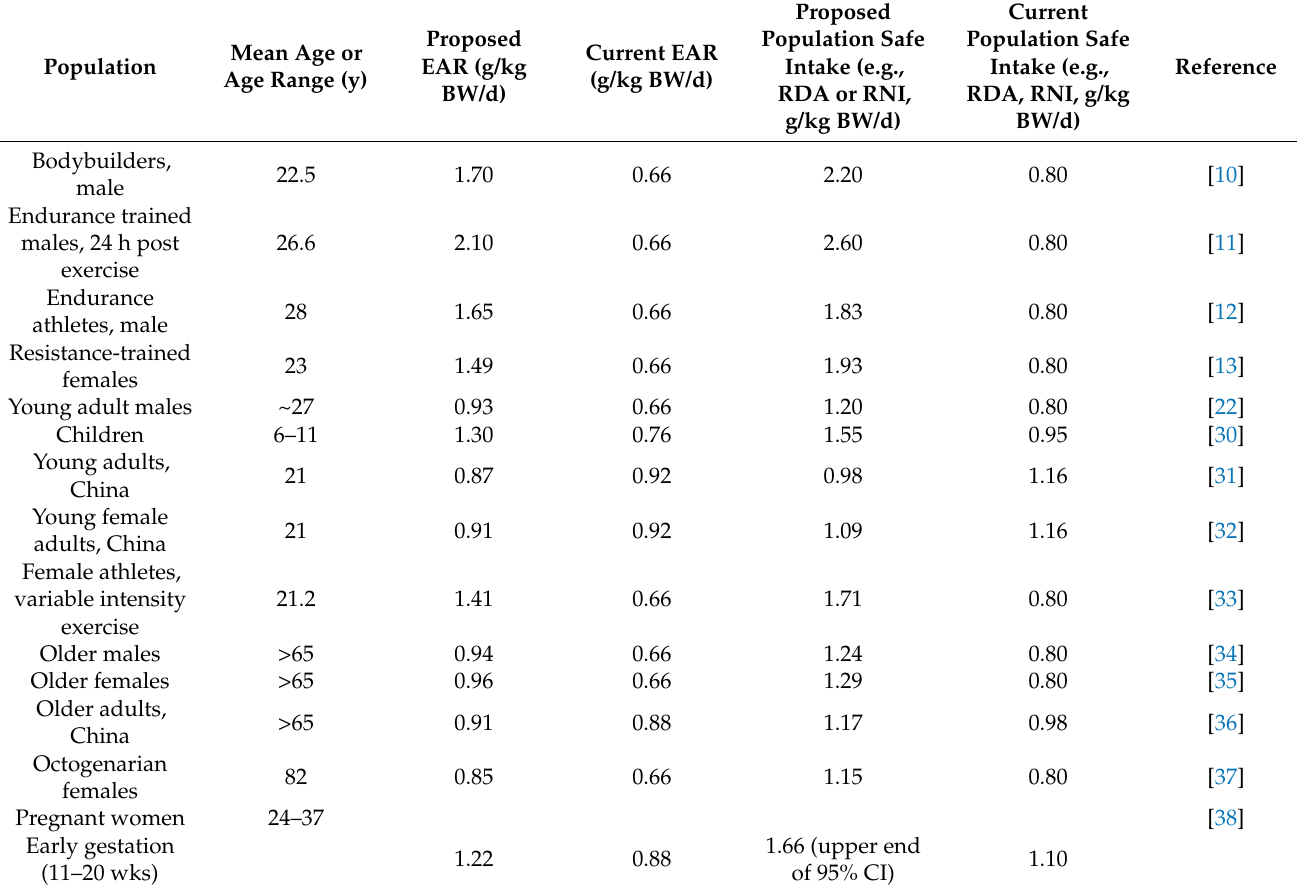
Table 1. Comparison of estimated protein requirements from IAAO studies relative to current recommendations (DRI RDAs or